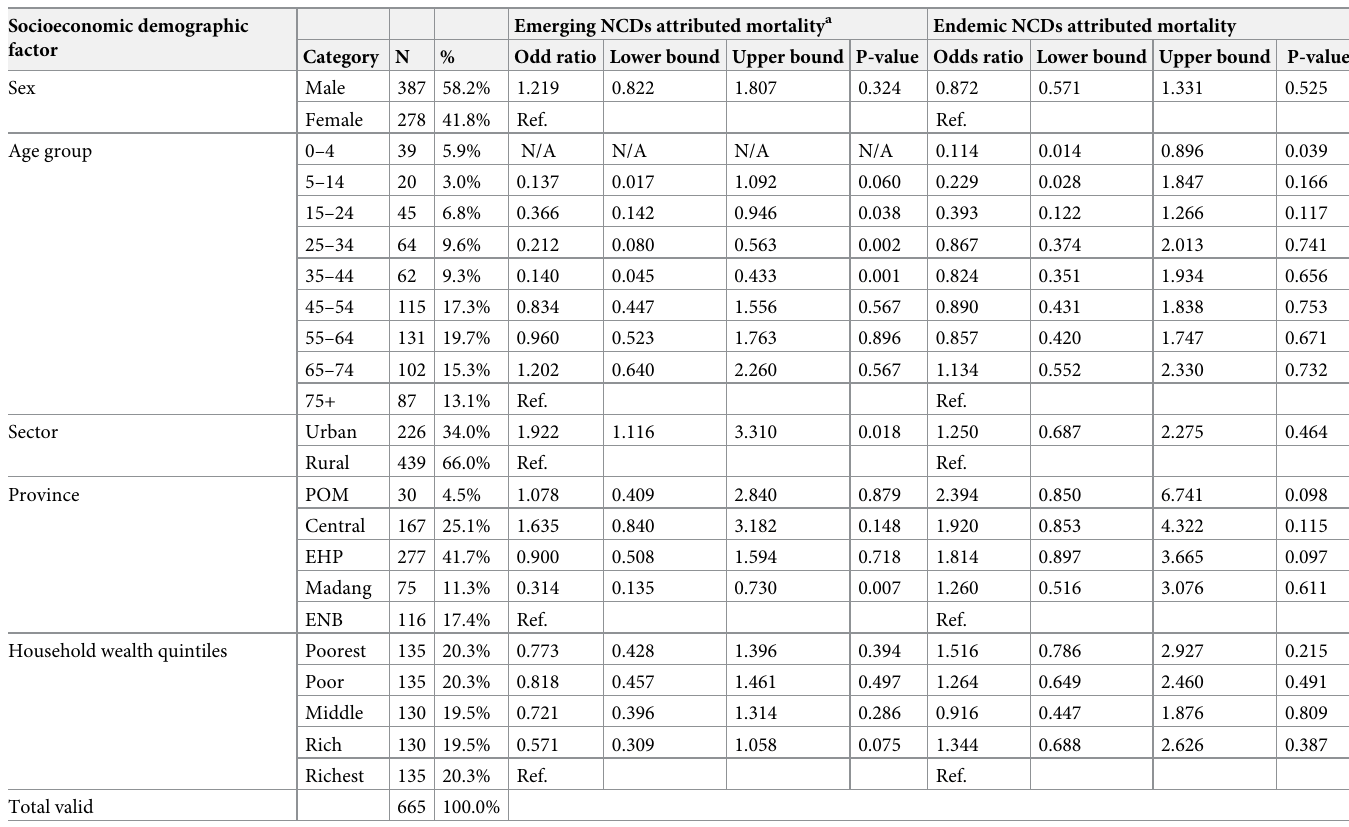
Table 2. Odds ratios of mortalities attributed to emerging NCDs and endemic NCDs among general population in Papua New Guinea PNGIMR’s CHESS, 2020. Socioeconomic demographic